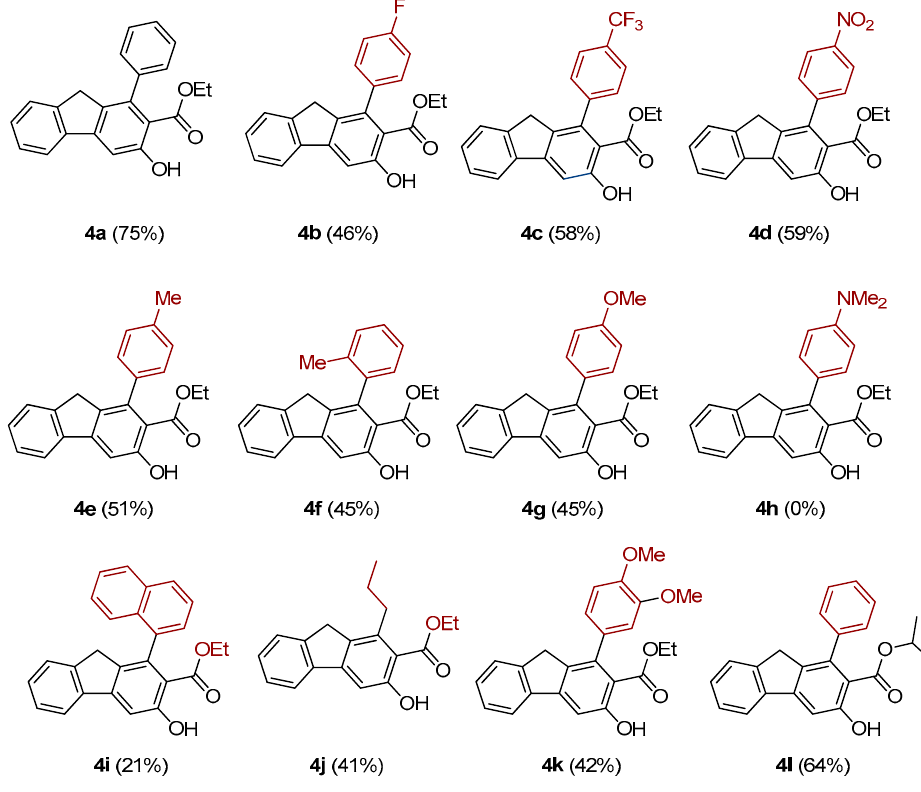
Table 2. Oxidation study of conversion of 2a and 3a into 4a 1 . Entry Oxidant Temp Yield 1 O 2 /CF 3 COOH 100 ◦ C trace 2 H 2 O 2 (1.0 eq) 80 ◦ C trace 3 Cu(OTf)(10 mol%)/bipy/NHPI/KI (1.0 eq) 2 80 ◦ C trace 4 CuBr(10 mol%)/LiBr(2.0 eq) 2 80 ◦ C 56% 5 DDQ (1.1 eq) RT 41% 6 3 DDQ (1.1 eq) 100 ◦ C